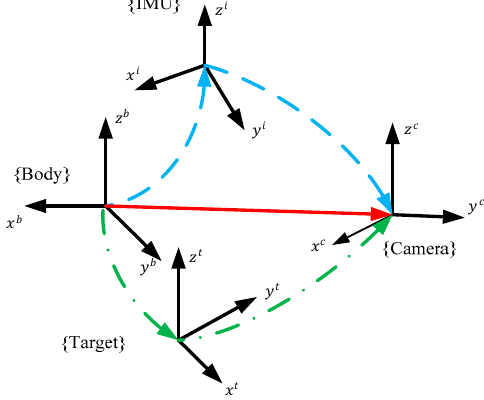
Figure 6. Transformation of the coordinate